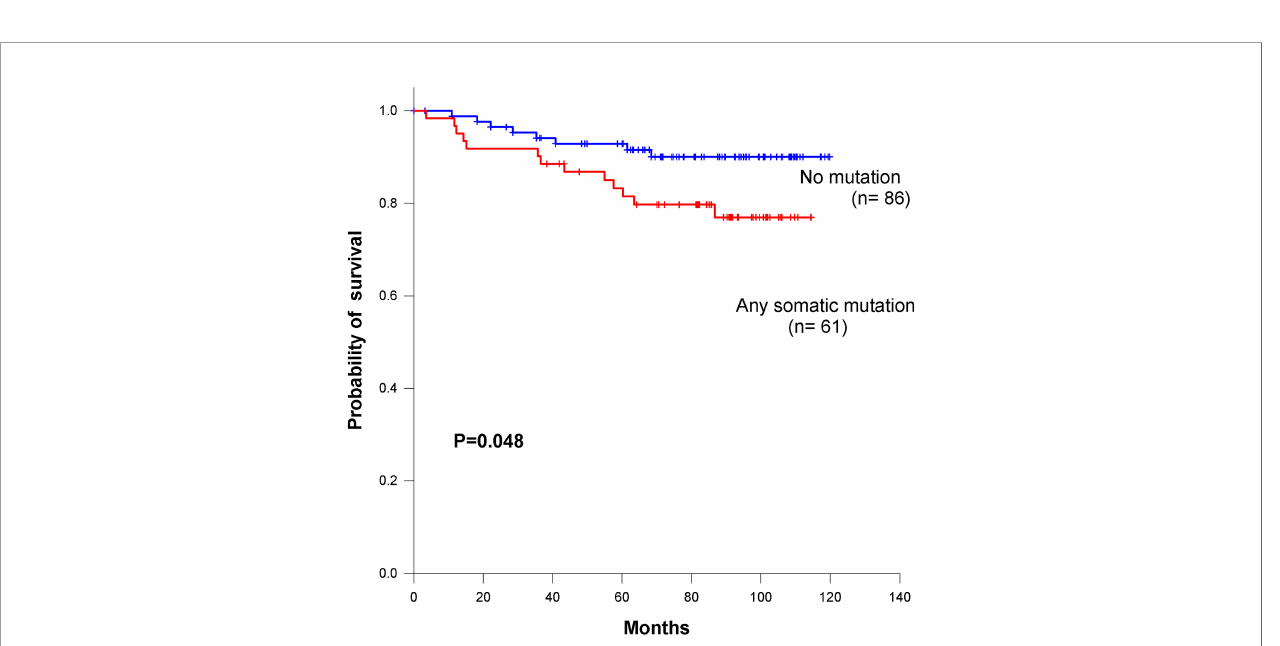
FIGURE 5 | Kaplan – Meier survival curves for overall survival based on kinase signaling pathway in breast cancer